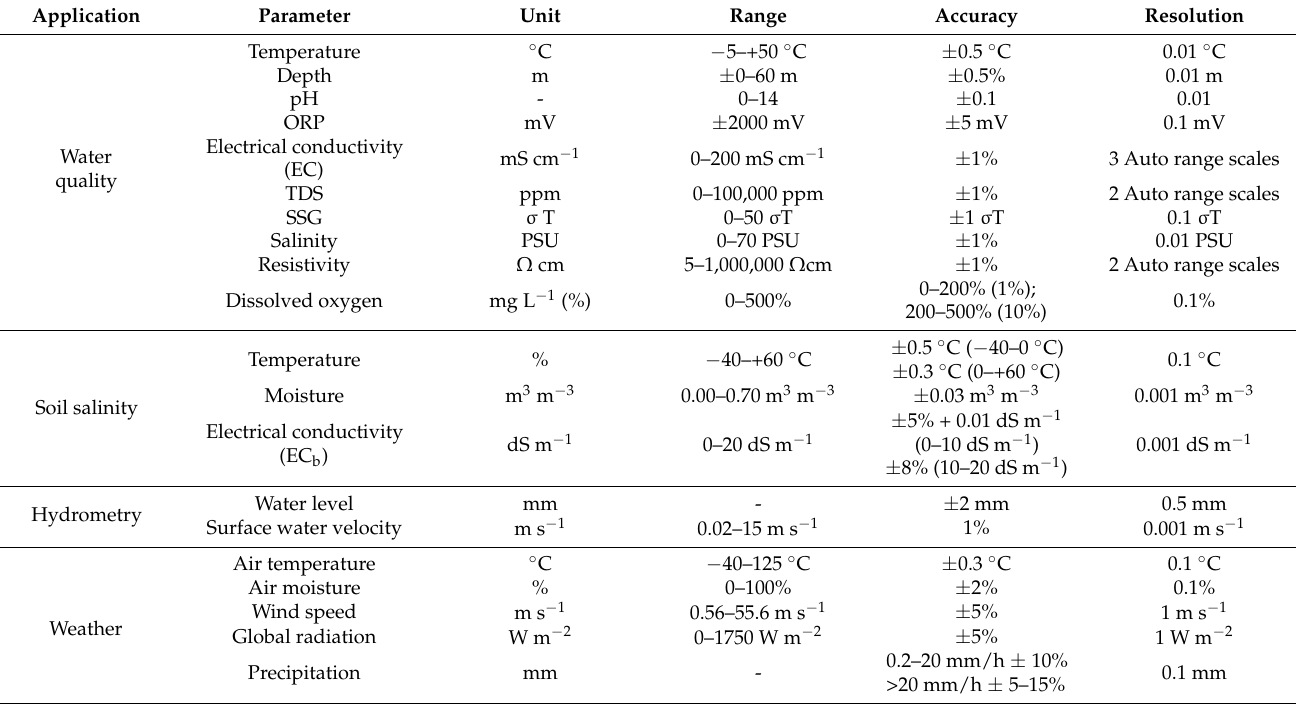
Table 1. Sensors integrated into ACMS with measuring parameters, ranges, accuracy, and